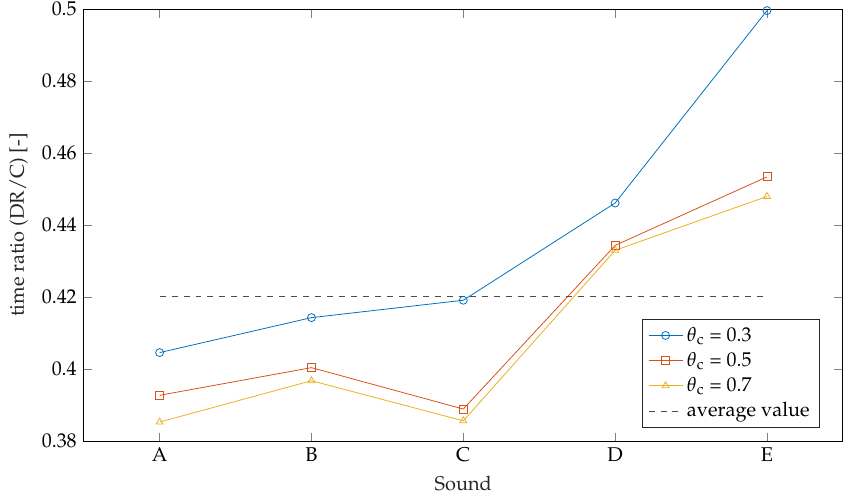
Figure 5. Analog to Figure 4, this picture presents relative running times of the Douglas–Rachford versus Condat algorithm. The only difference is that the Gabor transform now uses 2048 frequency